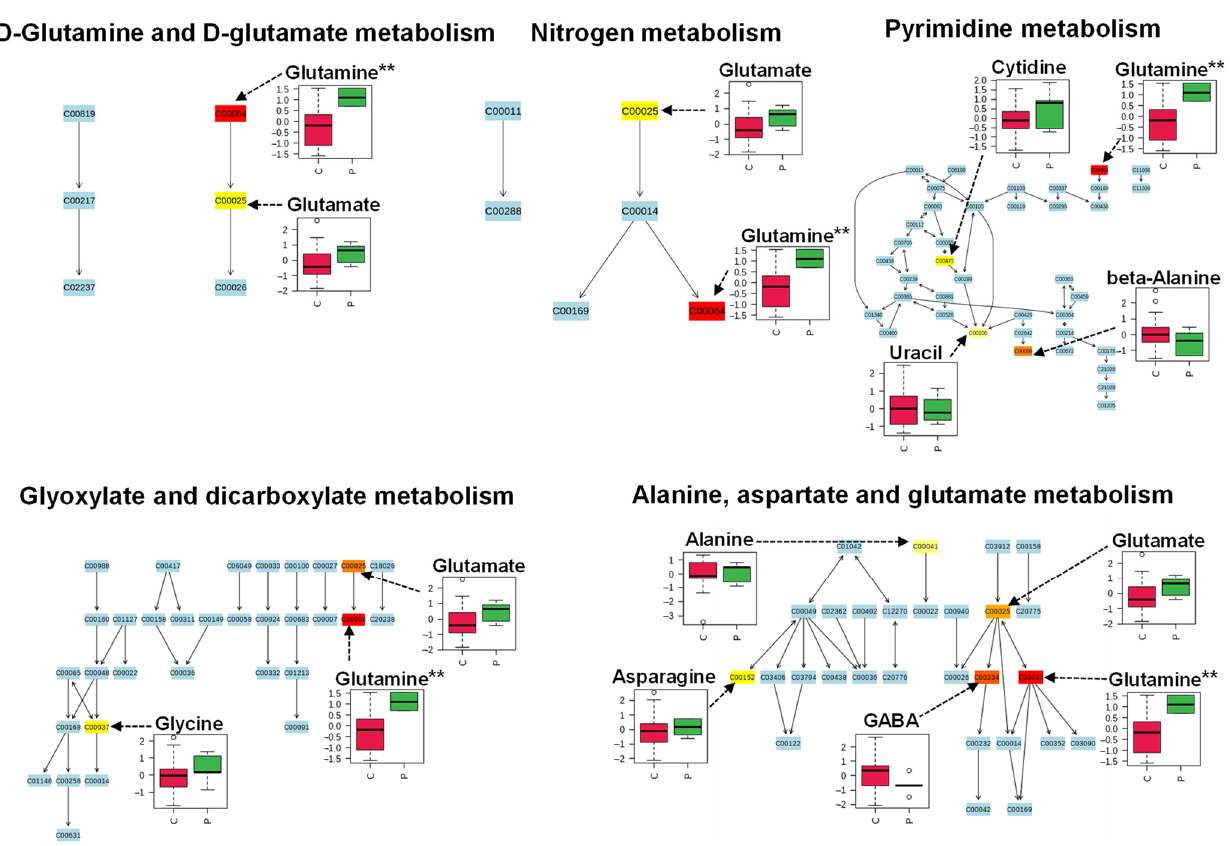
Figure A2. Detailed results of the pathway analysis in Figure 4a. Nodes with mapped data are colored. In each box plot, C and P indicate the data without and with depressive episodes, respectively. ** p < 0.01.